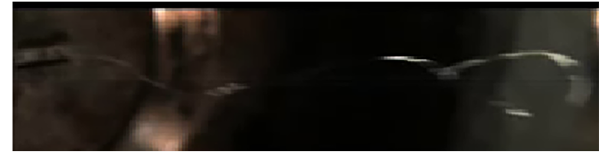
Figure 7: Motion trajectory of a meltblowing fi